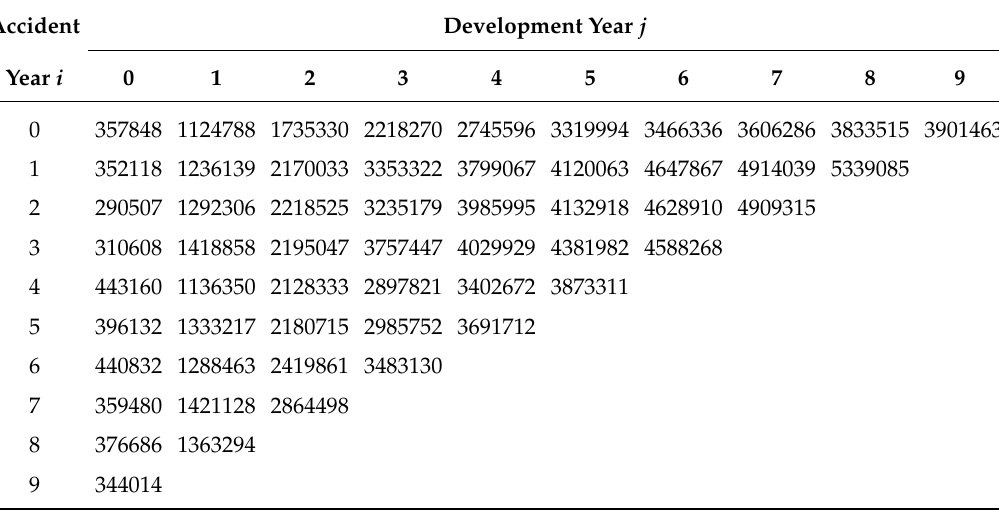
Table 1. Cumulative payments in the claims development triangle of Taylor and Ashe